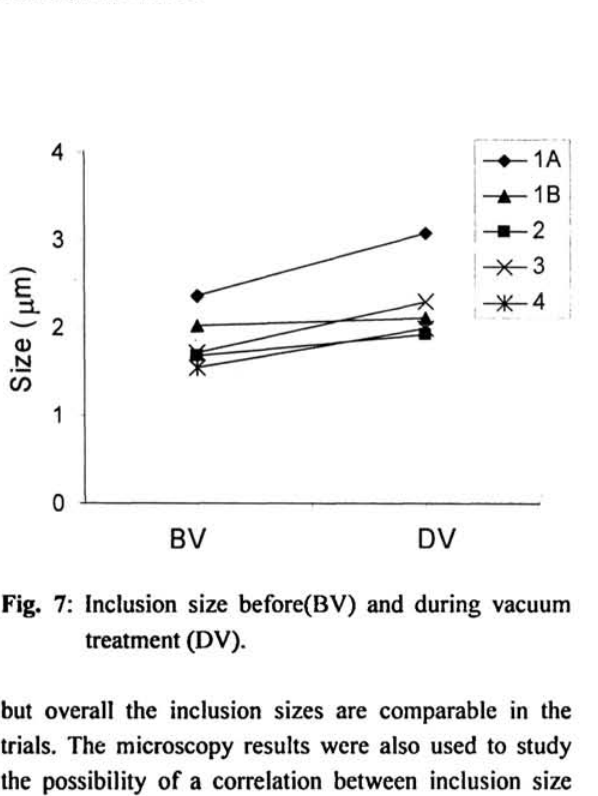
Fig. 7: Inclusion size before(BV) and during vacuum treatment